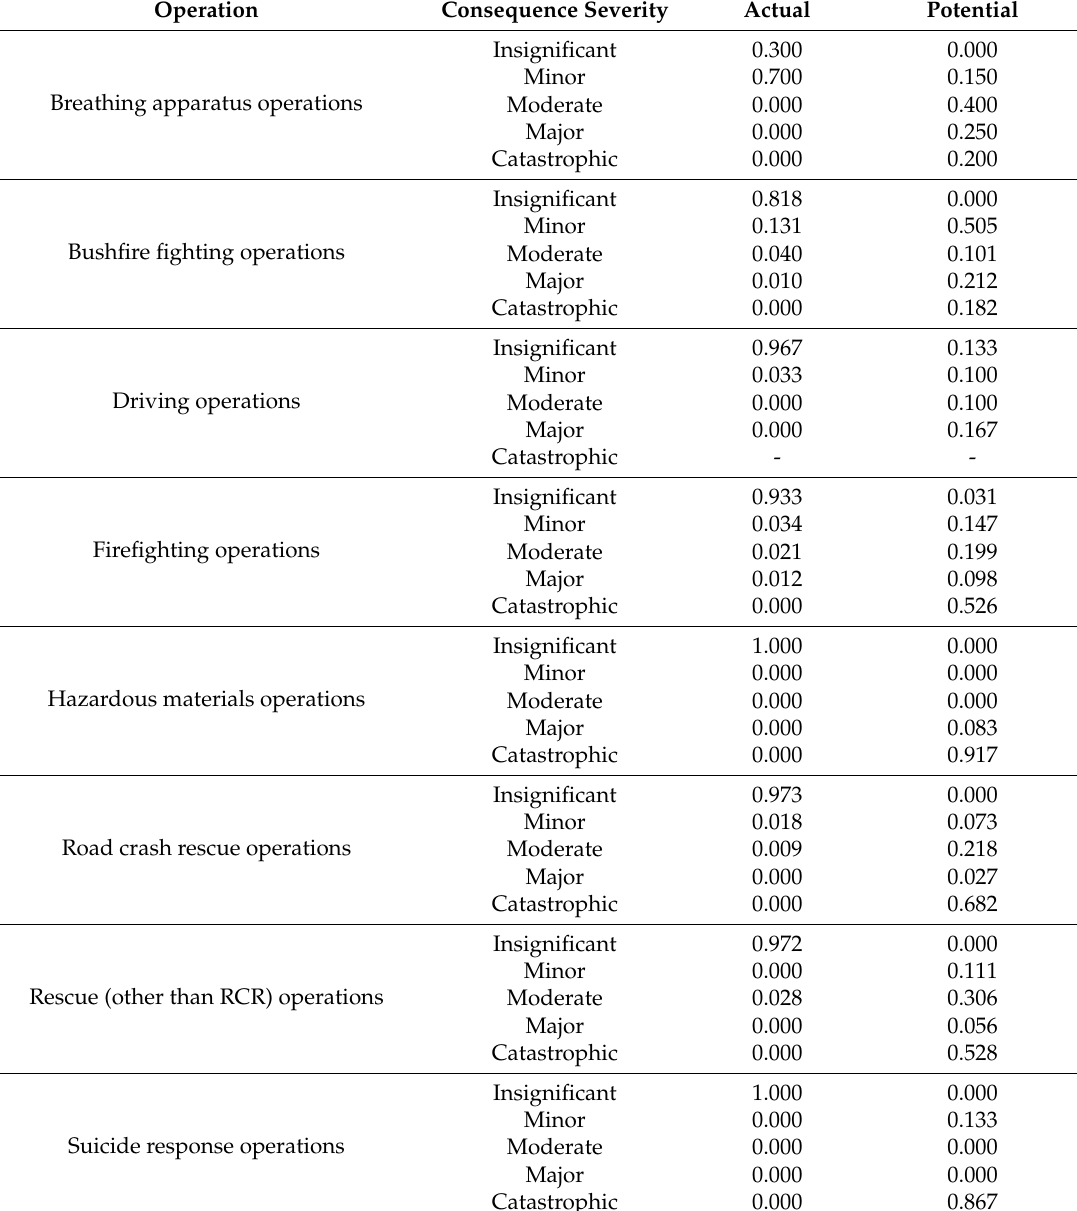
Table 6. Conditional probability of actual and potential consequence severity during